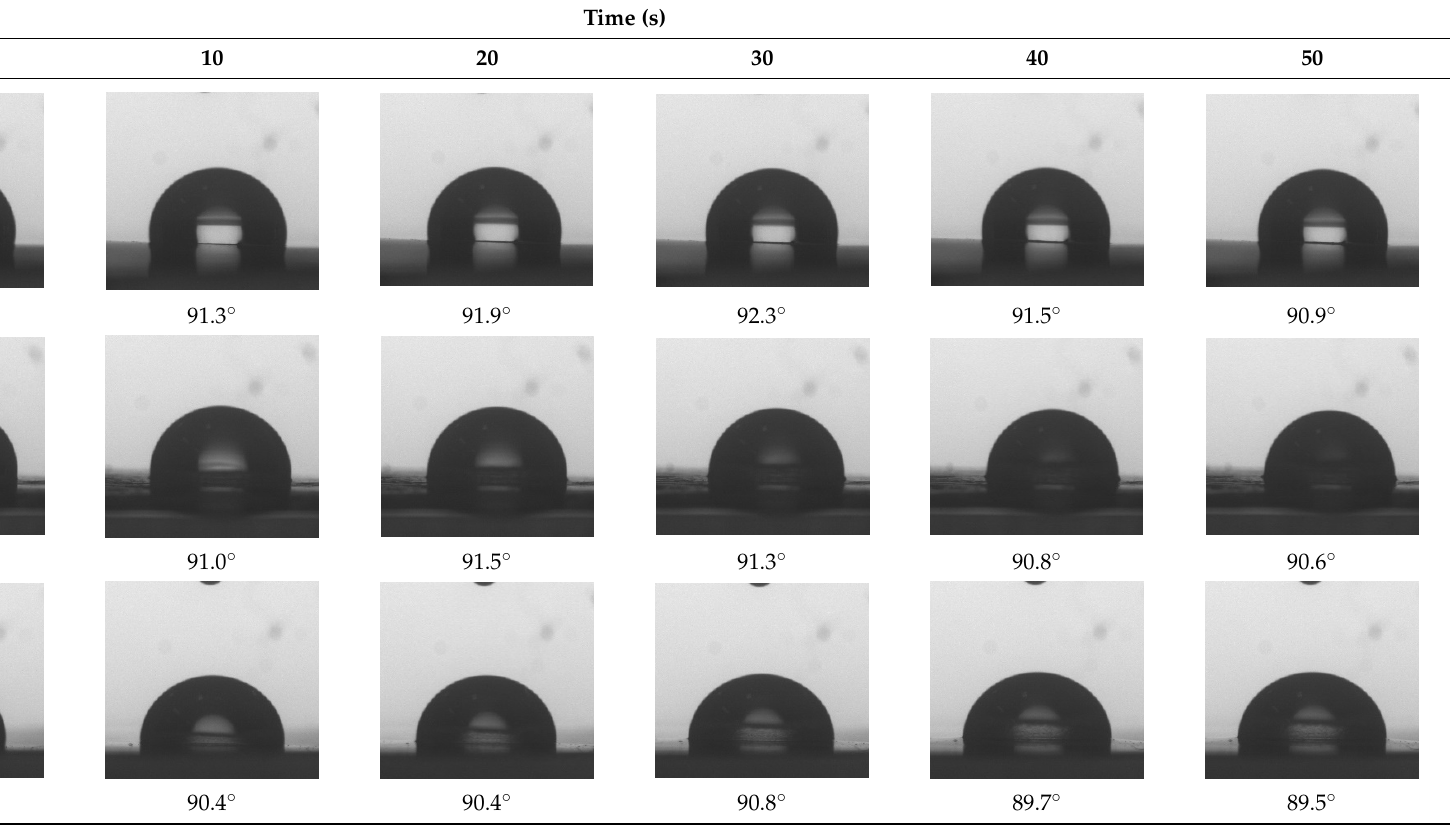
Table 1. Dynamic water contact angle images of native rice starch film and CMSr films synthesized with 10%, 20%, 30%, 40%, and 50% NaOH concentrations with time (0–50 s). Samples